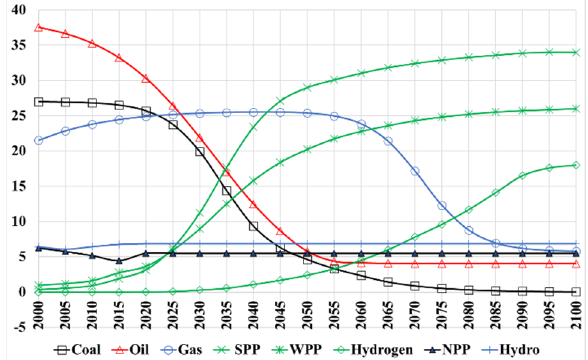
Figure 20. The dynamics of changes in the structure of the world fuel and energy balance (shares in energy consumption) for the 21st century (ambitious scenario) (for Coal, Oil, Gas, Solar Power Plants (SPP), Wind Power Plants (WPP), Hydrogen, Nuclear Power Plants (NPP) and Hydro en- ergy).